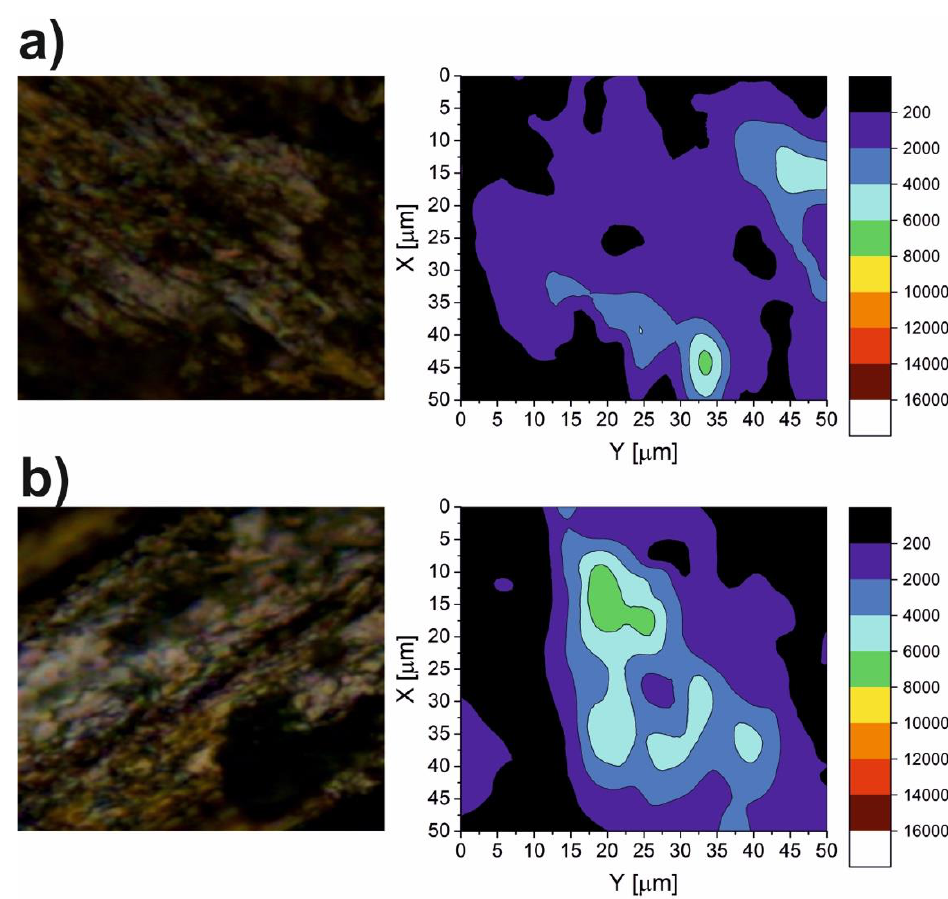
Figure 14. The Raman maps of Ni-10% CaF 2 ( a ) and Ni-20% CaF 2 ( b ) self-lubricating composites after wear test at 600 °C.